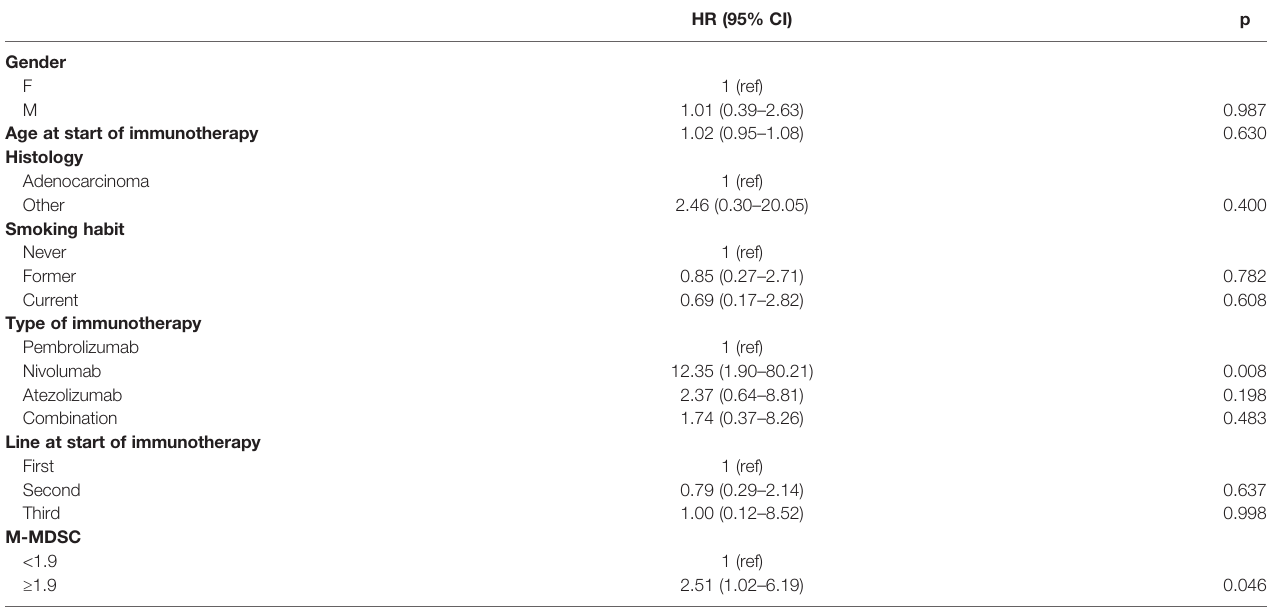
TABLE 2 | Univariate analysis for